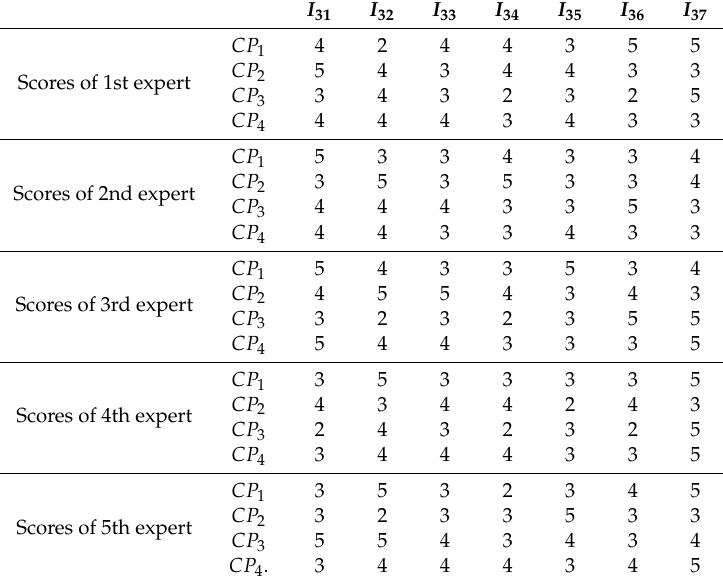
Table A13. Scores of the status level of the controlling process